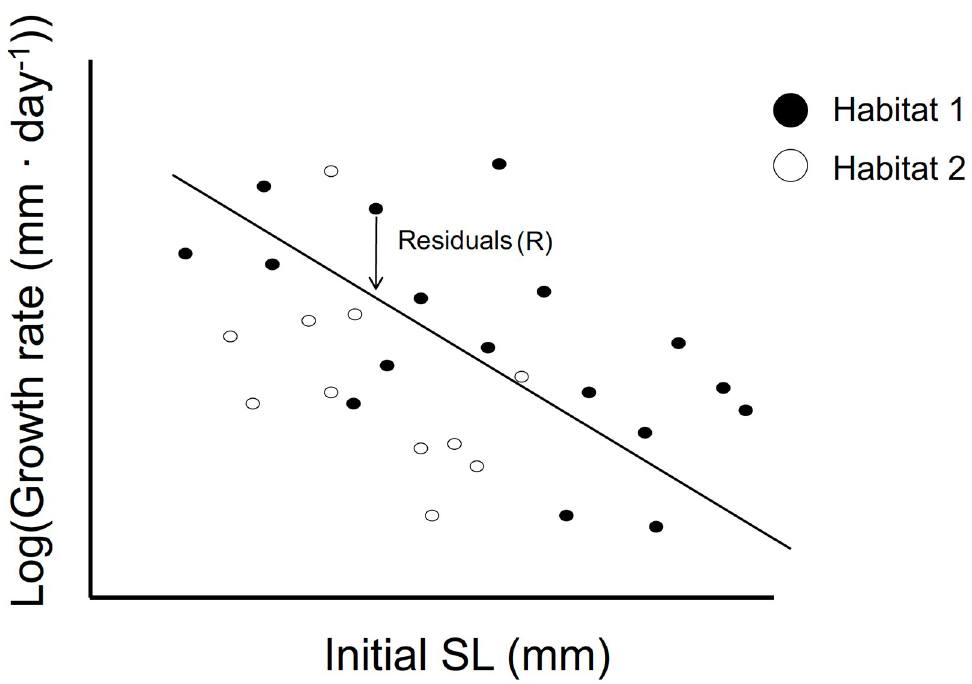
Fig 3. Use of residual values (R) from a size vs. growth rate regression to compare growth in different habitats. The arrow shows the distance from the points to the line. Mean residual values � R are calculated for all individuals in each habitat (r = restored, u = unrestored), and if � R > � R , then we conclude that growth is higher in restored than in r u unrestored habitats.